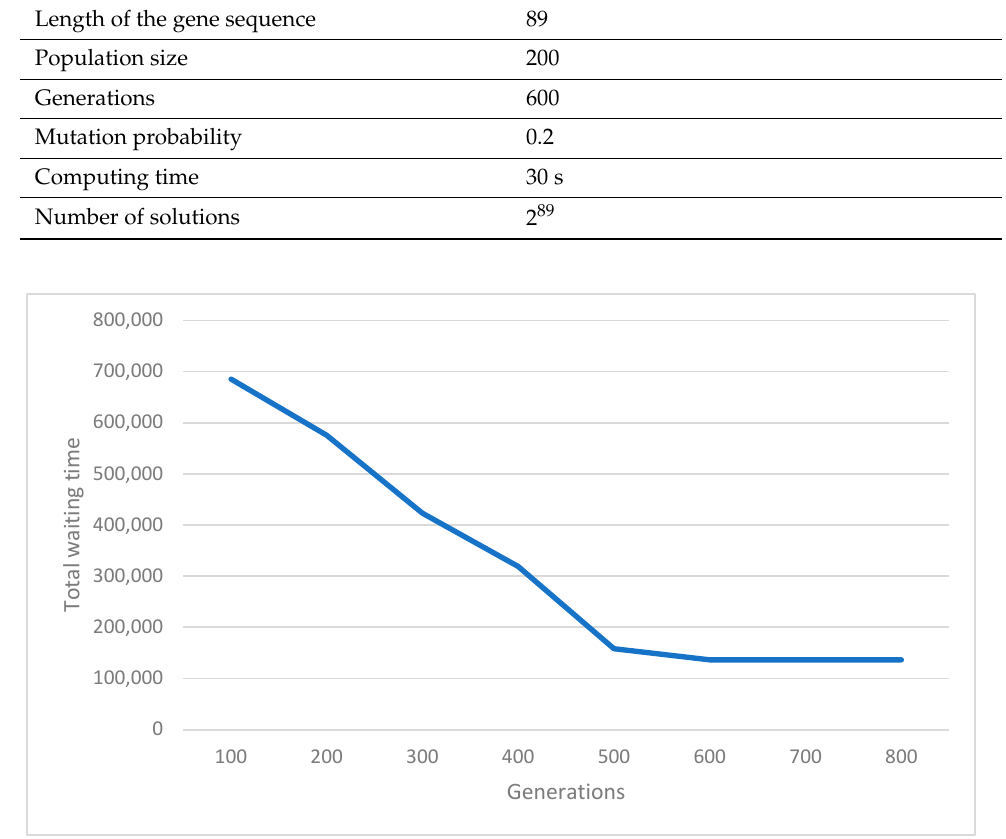
Figure 8. Convergence graph of GA_RPOM for the case study. Table 6. Operation strategies generated by RPOM and comparison of all passenger waiting times. 0 to 15